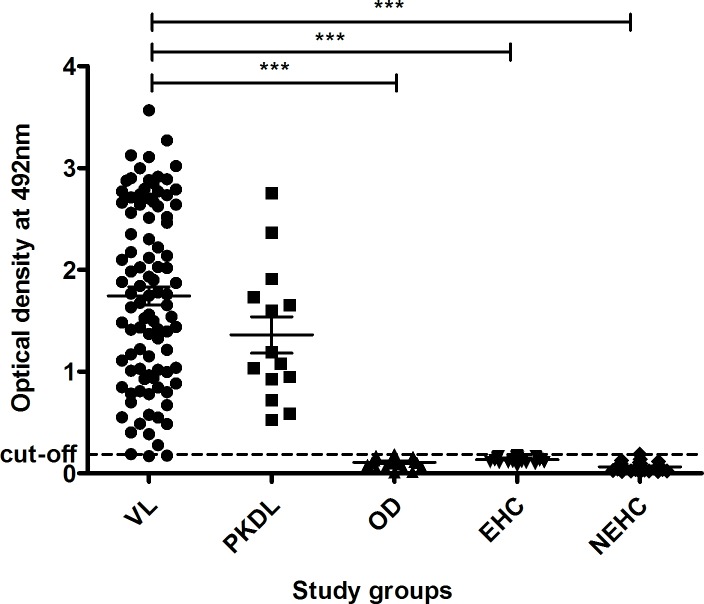
ELISA results with urine samples obtained from VL and PKDL patients, healthy individuals and other clinical groups.Comparative evaluation of ELISA reactivity of anti-Leishmania antibodies in urine against LAg at 0.1875 cut-off. The study groups were composed of a panel of VL patients (VL; n = 97), PKDL patients (n = 14), endemic healthy controls (EHC; n = 25), non-endemic healthy controls (NEHC; n = 25) and other diseases (OD; n = 25) including malaria (n = 2), viral fever (n = 2), tuberculosis (n = 4), typhoid (n = 4), liver abscess (n = 3), systemic lupus erythematosus (SLE) (n = 3), sepsis (n = 2), pancreatitis (n = 1), pneumonia (n = 1), filariasis (n = 1), abdominal pain and loose motion (n = 1), and mouth ulcer (n = 1). Each sample was tested in duplicate and the mean was taken. Each dot represents mean of a single sample.